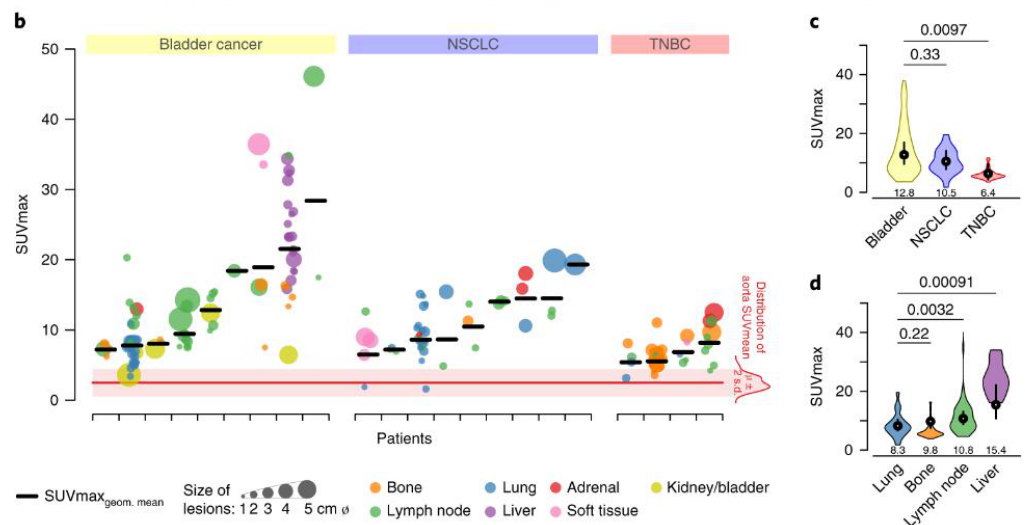
Figure 2. 89 Zr-atezolizumab tumor uptake. ( a ) Examples of PET / CT images of four patients illustrating 89 Zr-atezolizumab tumor uptake in five di ff erent locations on day 7 post injection (white arrows indicate tumor lesions; PET scans were performed once per patient and time point). Images (i) and (ii) are from the same patient, whereas images (iii), (iv), and (v) are from a separate patients. ( b ) Overview of 89 Zr-atezolizumab uptake as SUVmax at day 7 post injection in 196 tumor lesions with a diameter > 2cm grouped per tumor type and ordered by increasing geometric mean SUVmax per patient, visualizing tumor size and site, and with blood pool background uptake as reference. Horizontal bar indicates geometric mean SUVmax per patient. ( c ) Violin plot of actual distribution of SUVmax in lesions per site of lesion with bottom and top 1% of SUVmax values truncated (first, fiftieth, and ninety-ninth SUVmax percentiles: 1.7, 7.9, 19.6 for lung; 3.9, 5.6, 16.4 for bone; 4.6, 9.7, 40.1 for lymph node; 16.1, 23.3, 34.1 for liver); black vertical lines are 95% CIs of geometric mean SUVmax; white dots within black lines and values below the violin plot are the actual geometric means, all based on a linear mixed regression model with two-sided Wald p values using Satterthwaite approximations to degrees of freedom under restricted maximum likelihood, shown above the graph; n lung = 44 in ten patients, n bone = 62 in nine patients, n lymph node = 54 in 20 patients, n liver = 19 in one patient. ( d ) Violin plot of SUVmax in lesions per tumor type with bottom and top 1% of SUVmax values truncated (first, fiftieth, and ninety-ninth SUVmax percentiles: 3.6, 10.9, 38.0 for bladder; 1.7, 9.7, 19.6 for NSCLC; 3.4, 5.6, 11.7 for TNBC); black vertical lines are 95% CIs of geometric mean SUVmax; white dots within black lines and values below the violin plot are the actual geometric means, all based on a linear mixed regression model with two-sided Wald p values using Satterthwaite approximations to degrees of freedom under restricted maximum likelihood, shown above the graph; n bladder = 85 in nine patients, n NSCLC = 43 in nine patients, n TNBC = 68 in four patients from